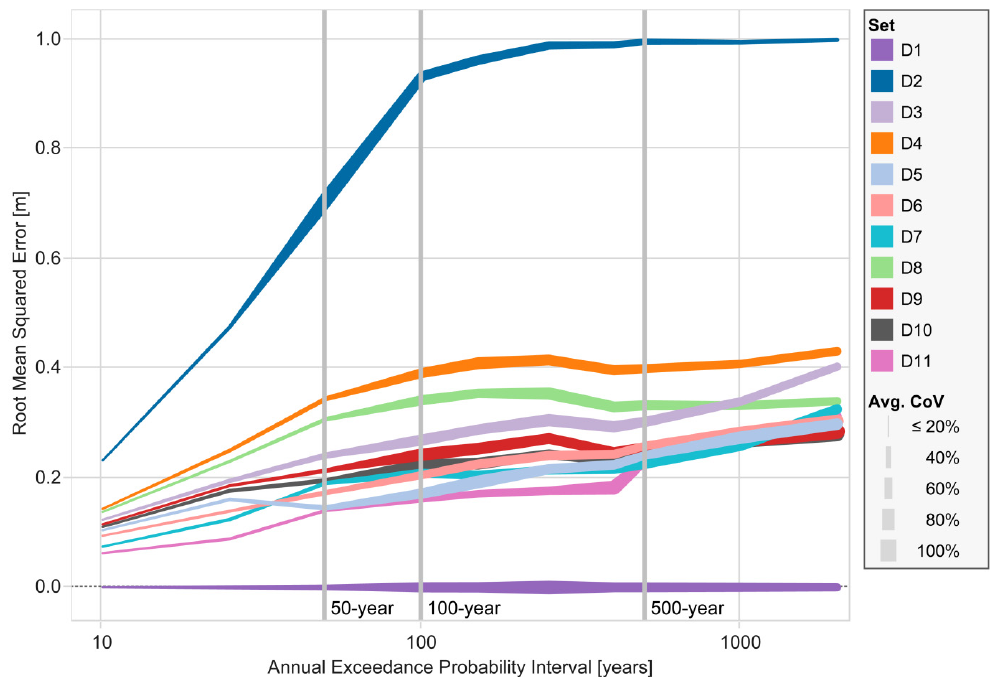
Figure 4. Average bias and variance by exceedance interval for each modeled storm suite.